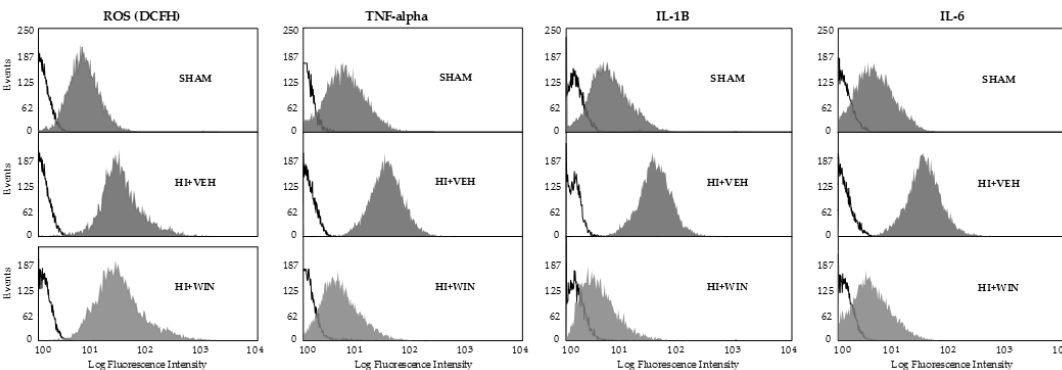
Figure 2. Representative fluorograms obtained after flow cytometry analysis showing ROS, TNF- α , IL-1 β , and IL-6 fluorescence. Samples of di ff erent brain regions from both hemispheres were analyzed in triplicate by flow cytometry ( n = 6) for each animal and condition. Black lines correspond to auto-fluorescence, whereas grey areas correspond to positive cells. Sham, n = 6; HI + VEH, n = 6; HI + WIN, n = 6.